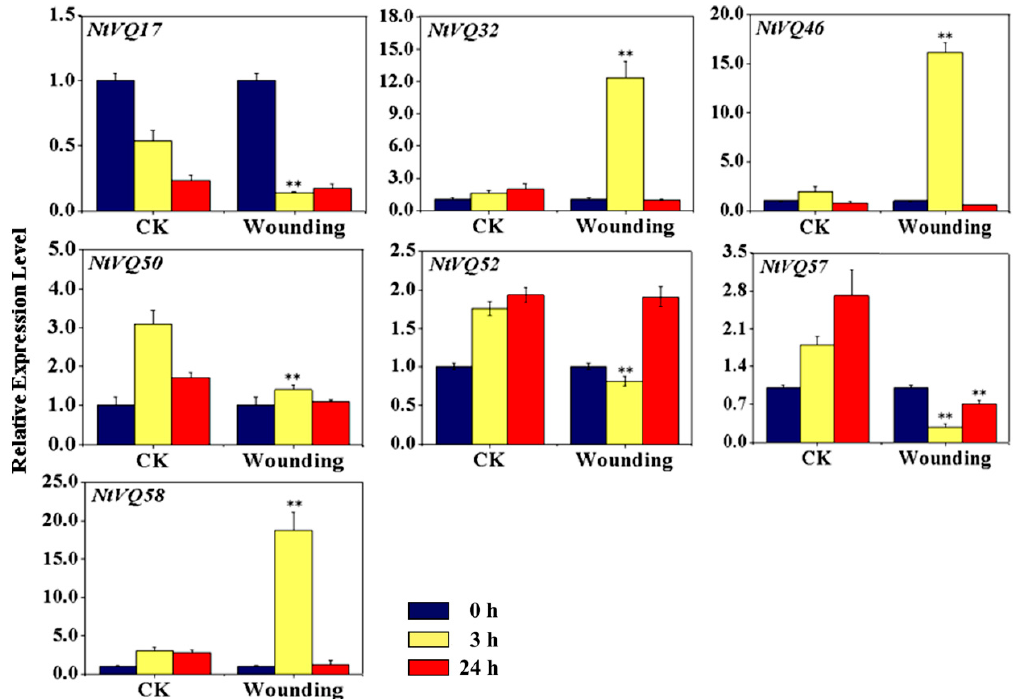
Figure 6. Expression analysis of significantly modulated NtVQ genes in response to mechanical wounding. Two-week-old seedlings were treated with wounding for 0, 3 and 24 h, respectively, before collected for RNA isolation and qRT-PCR. The relative expression value of each NtVQ gene was normalized to NtEF1 α with CK at 0 h as calibrator. CK, control group without wounding. * indicates the level of significance relative to the CK value (* p < 0.05, ** p < 0.01).